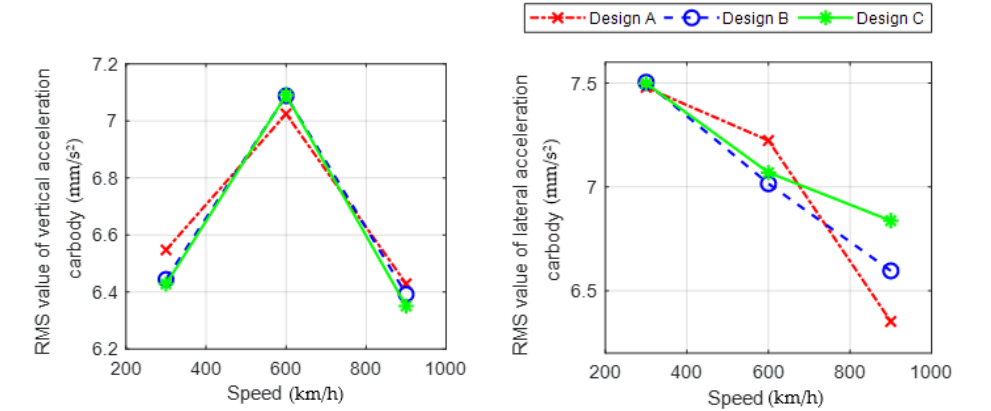
Figure 25. RMS value of the vertical/lateral acceleration with respect to speed.